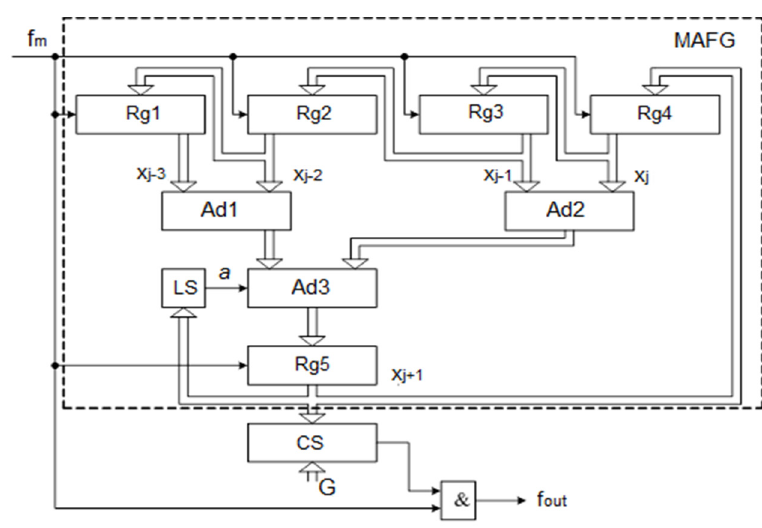
Figure 1. PPSG structural scheme based on MAFG.